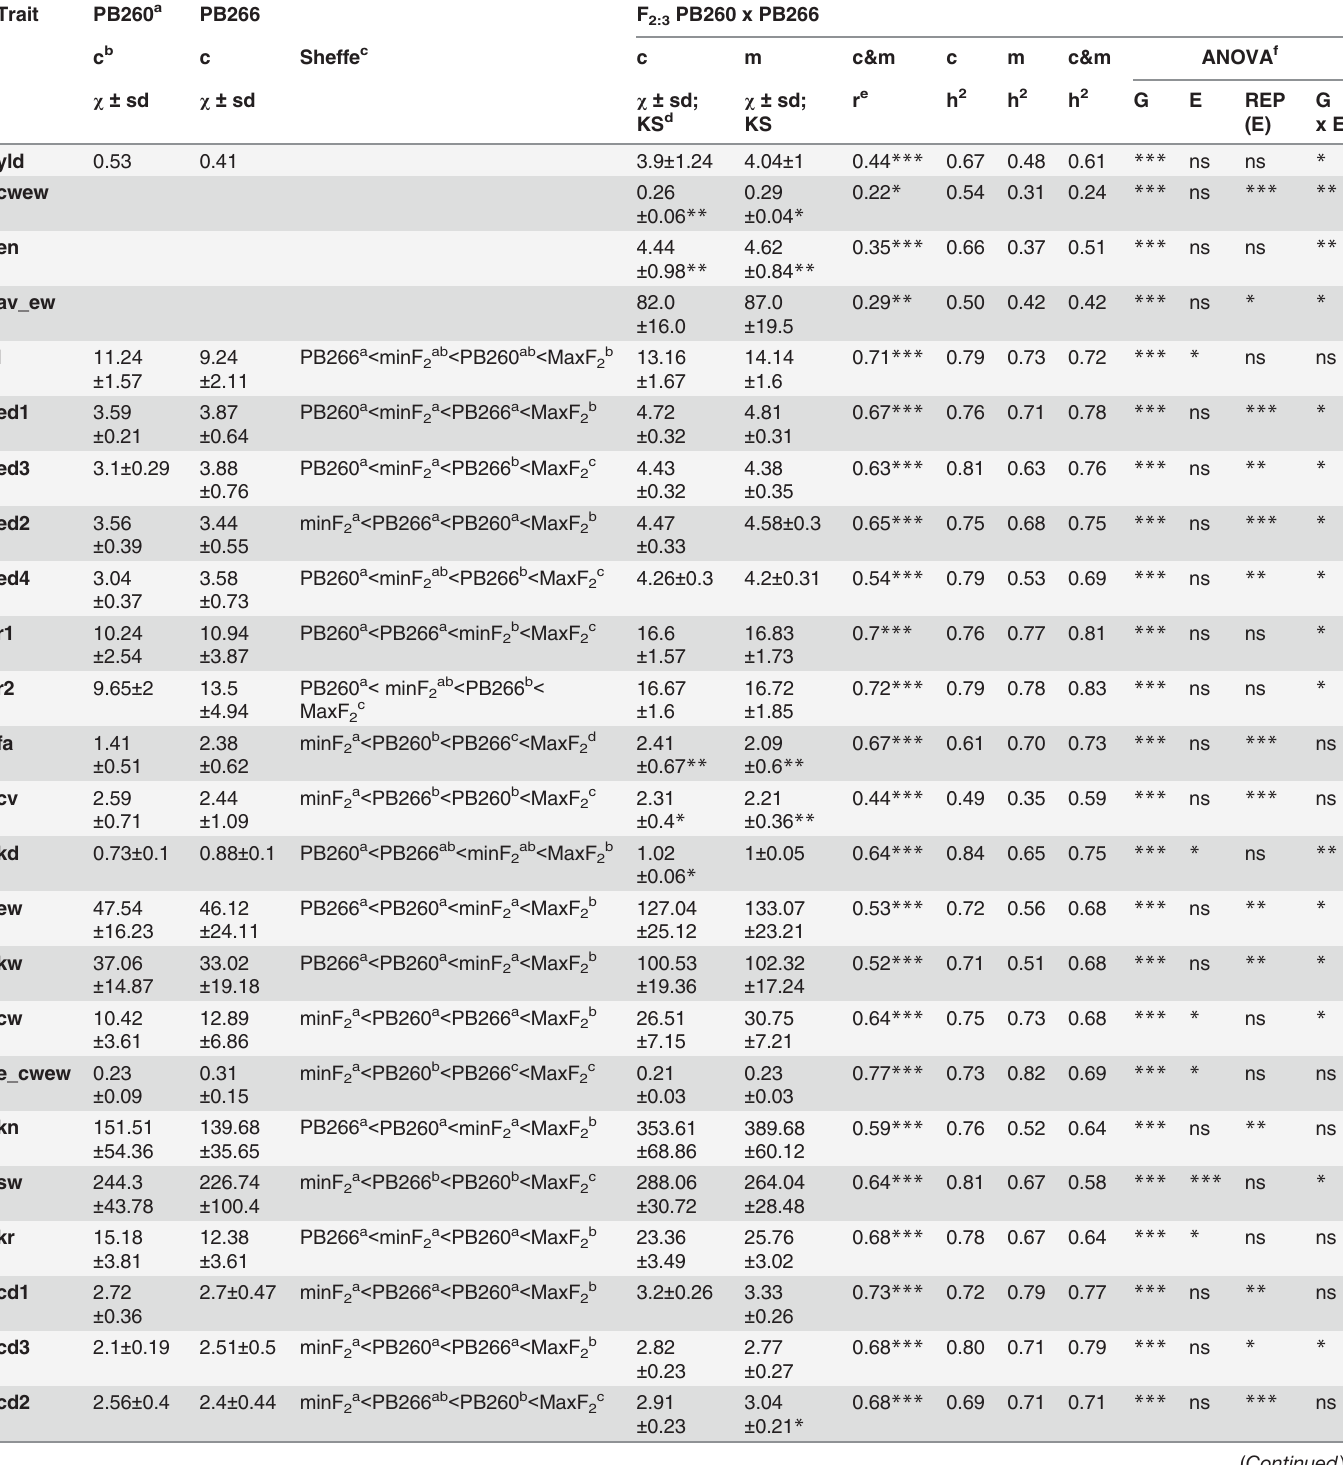
Table 2. Phenotypic values (mean ± standard deviation) of the parental inbred lines PB260 and PB266, respective F 2:3 families and quantitative ge- netic parameters for ear fasciation and related